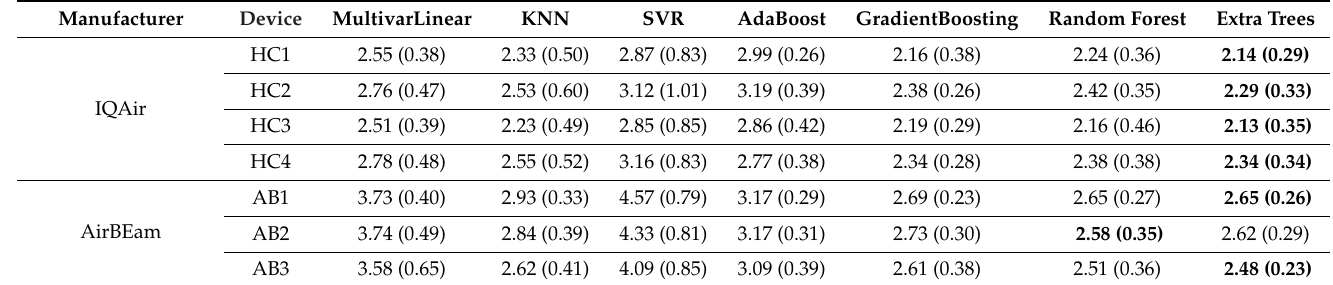
Table 1. Cross-validated RMSE values of different monosensor calibration methods for calibrating PM 2.5 sensor values (IQAir and AirBeam). The cross-validation has been performed on training data using 10 folds. Values in parenthesis are the standard deviation of the RMSE values obtained in the 10 folds. Bold numbers indicate the best values in each row.